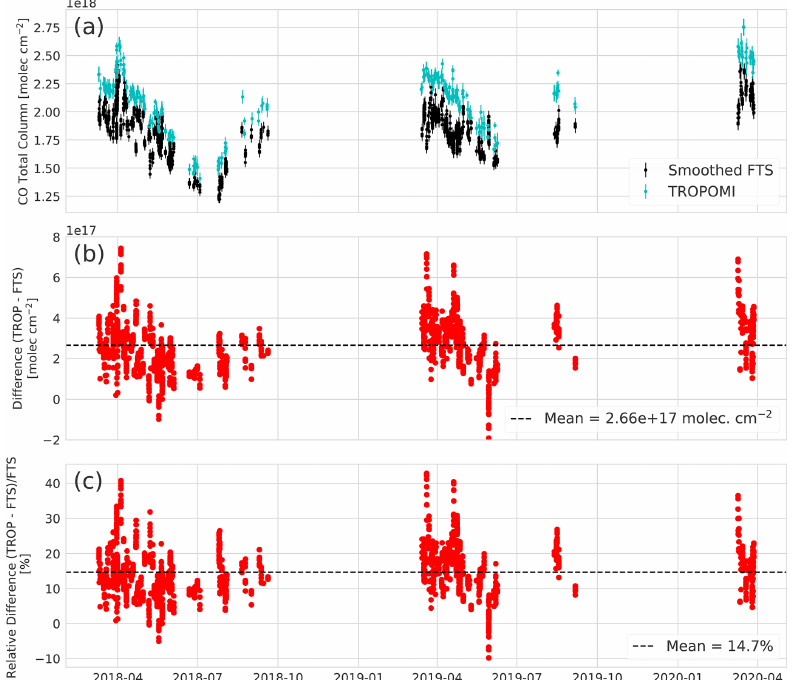
Figure 9. Time series of (a) TROPOMI and smoothed PEARL-FTS total columns, (b) absolute column differences (in molec.cm − 2 ), and (c) relative differences (in %). The error bars in the top panel represent the measurement uncertainties of both the PEARL-FTS and TROPOMI.